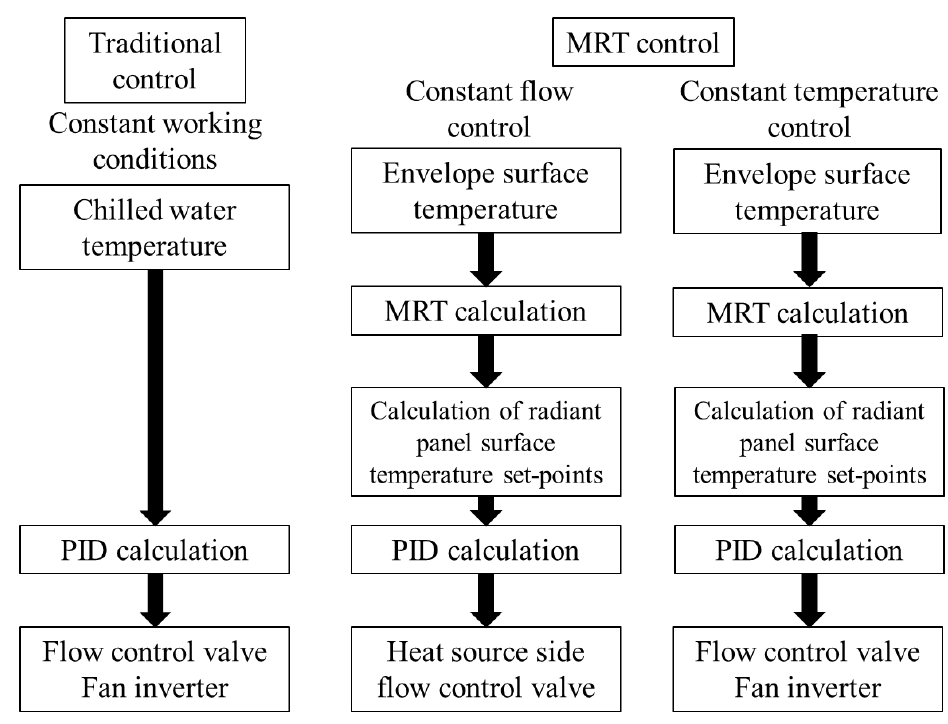
Figure 11. Schematic flow chart of the MRT control.